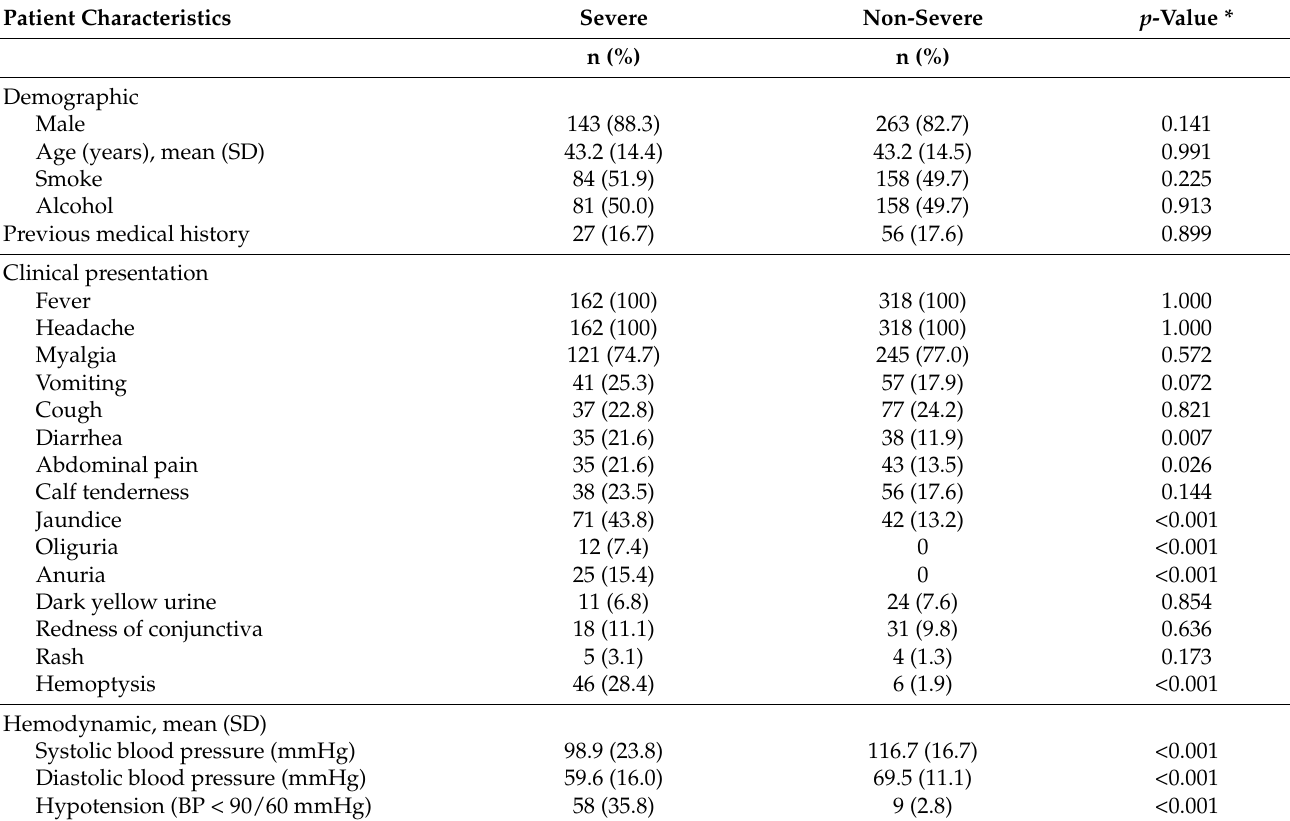
Table 1. Demographic and clinical profiles of patients with non-severe and severe